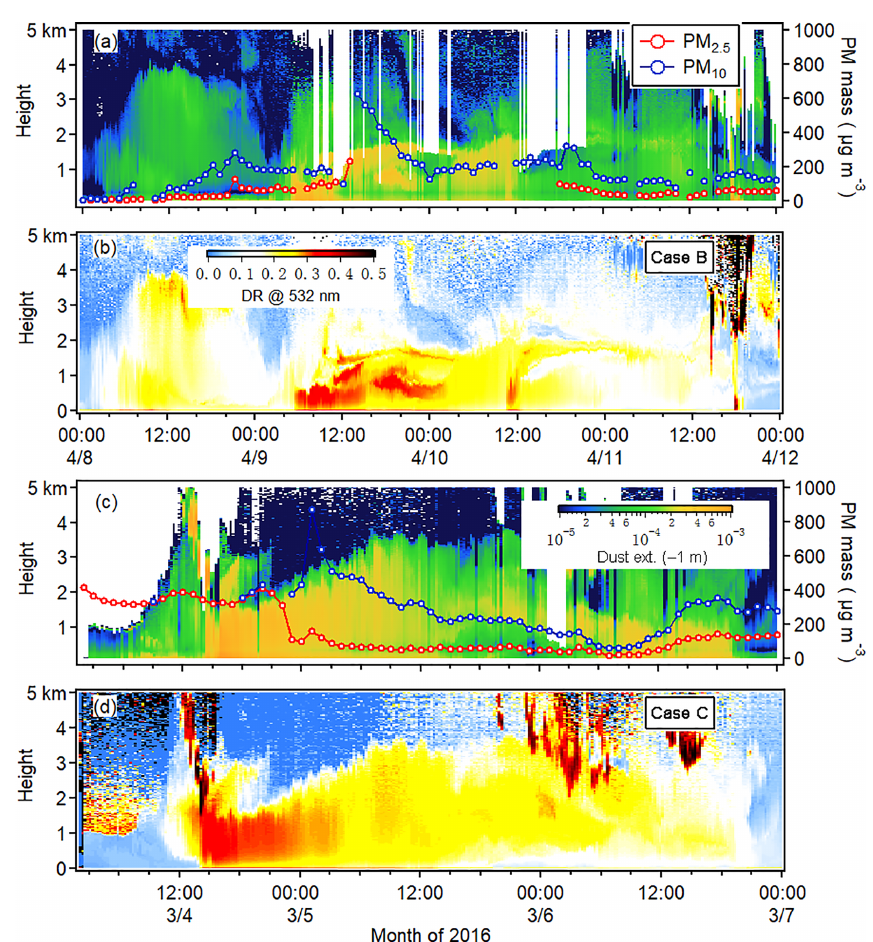
Figure 8. Time–height indications of the dust extinction coefficient and the δ value at 532nm derived from polarization-sensitive lidar measurement in Beijing in case B and case